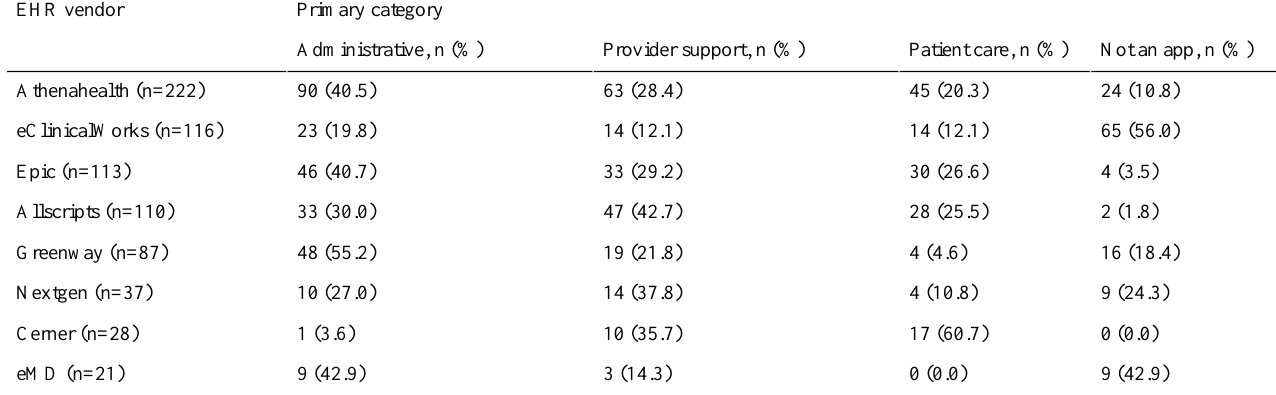
Table 1. Distribution of app marketplace offerings across primary categories by electronic health record (EHR)